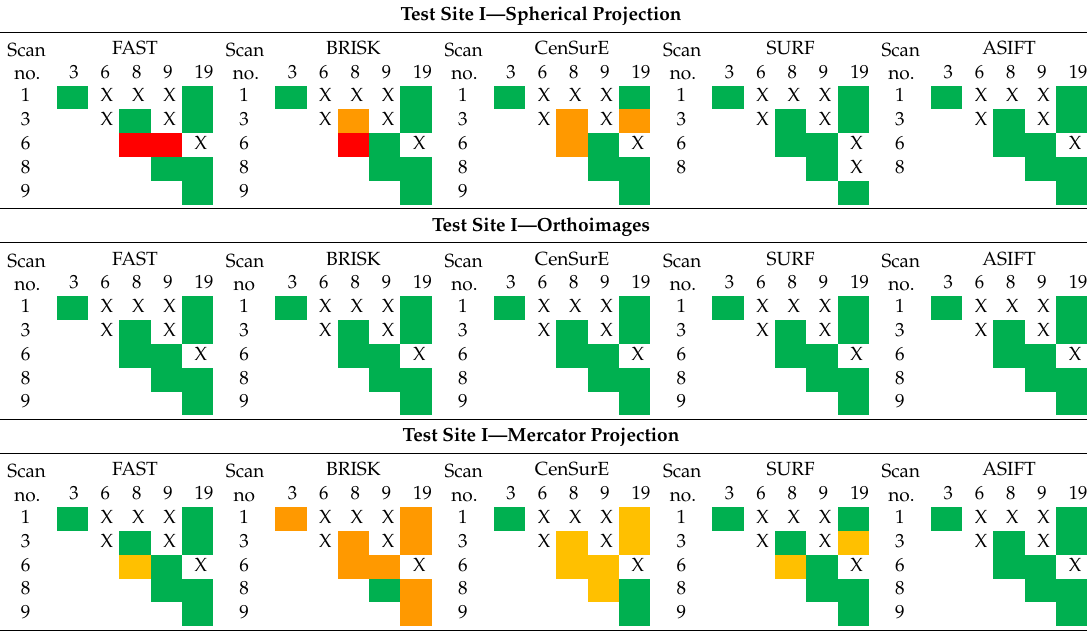
Table 2. The accuracy of the automated registration of scans for Test Site I (both scenarios): green, correct matching (full registration); orange, preliminary orientation requiring final registration using the Iterative Closest Point (ICP) method; and red, no matching. “x” indicates no connection between scans (no overlap). Test Site I—Spherical Projection